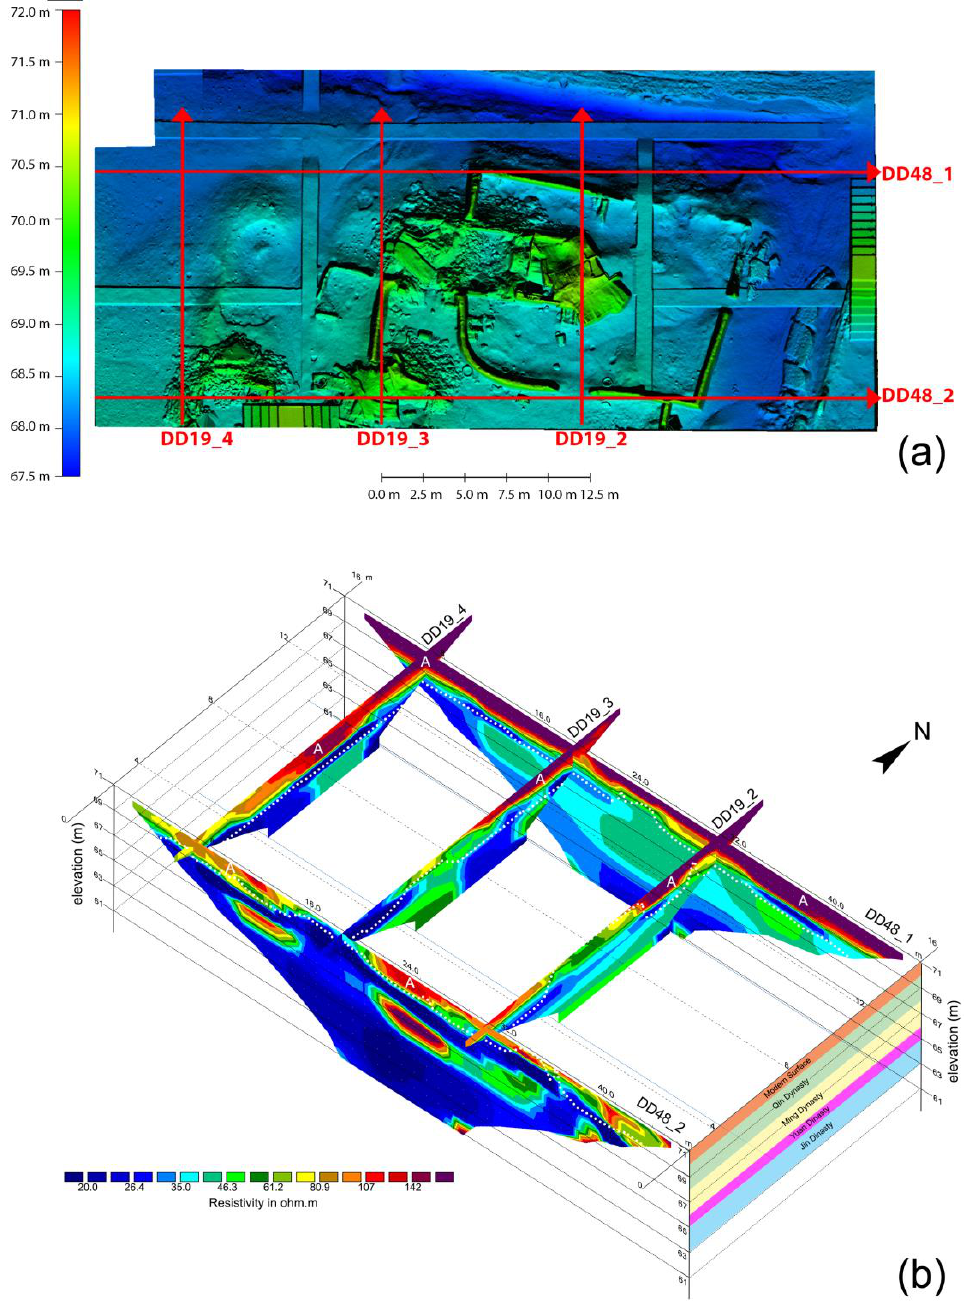
Figure 8. ( a , b ) ERT profiles. Upper panel: location of the ERT profiles on the DEM. Lower panel: The image shows the 5 ERT profiles acquired. All the distances are expressed in meter. The axes have been rescaled with different factors in order to improve the comprehensibility of the whole image. The capital letter “A” marks the presence of the shallow resistivity layer of about 2–2.5 m. The white dotted line represents the topographic level, extracted from the DEM, after the archaeological excavations. The archaeological stratigraphy on the right site of the image is extrapolated from Figure 2 and related to the adjacent excavated area (B in Figure